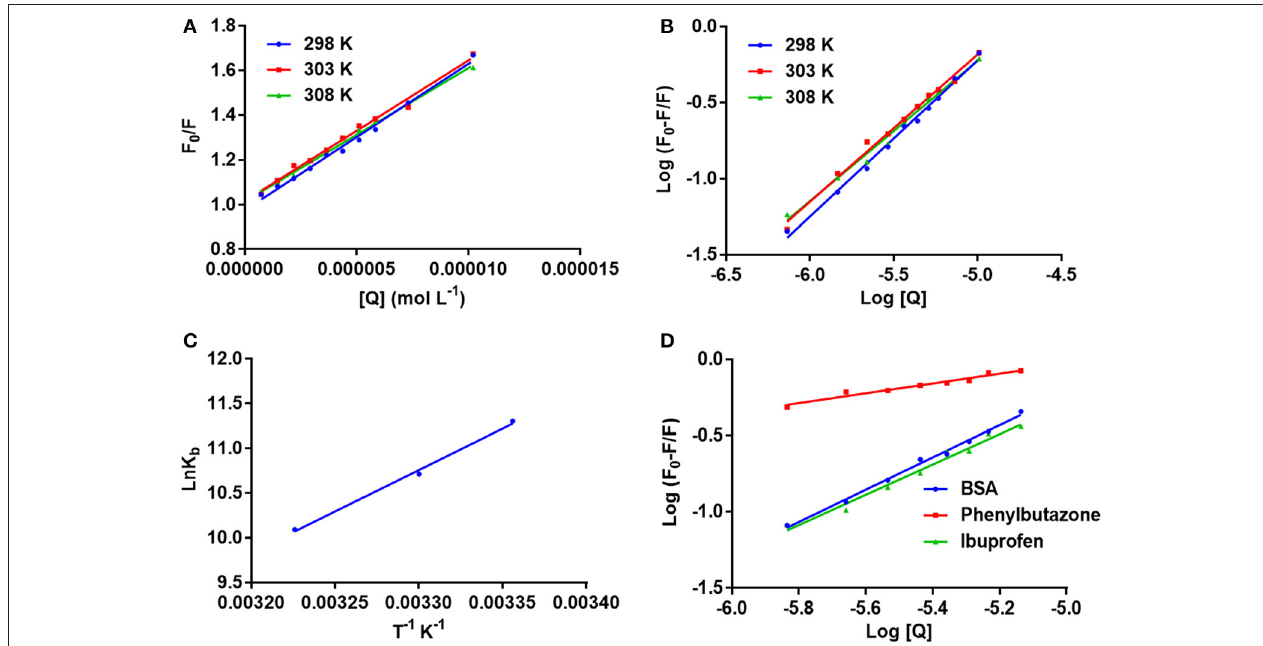
FIGURE 3 | (A) The stern–Volmer curves for the quenching of BSA by neratinib at 298/303/308K; (B) The plot of log[(F 0 -F)/F] vs. log[Q] for quenching process of neratinib with BSA at 298/303/308K; (C) Van’t Hoff plots for the binding interaction of neratinib with BSA; (D) The plot of log[(F 0 -F)/F] vs. log[Q] for quenching process of neratinib with BSA in presence of site markers phenylbutazone and ibuprofen at 298K.